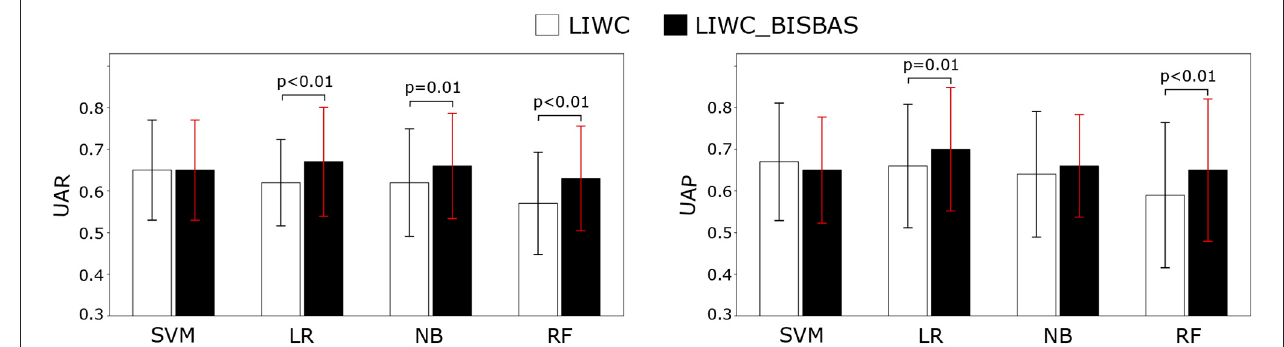
FIGURE 1 | Unweighted average recall (UAR) and unweighted average precision (UAP) for the four classifiers given Language Inventory Word Count (LIWC) features, and for a concatenation of LIWC features, Behavioral Inhibition System and Behavioral Approach System personality features (LIWC_BISBAS), respectively.